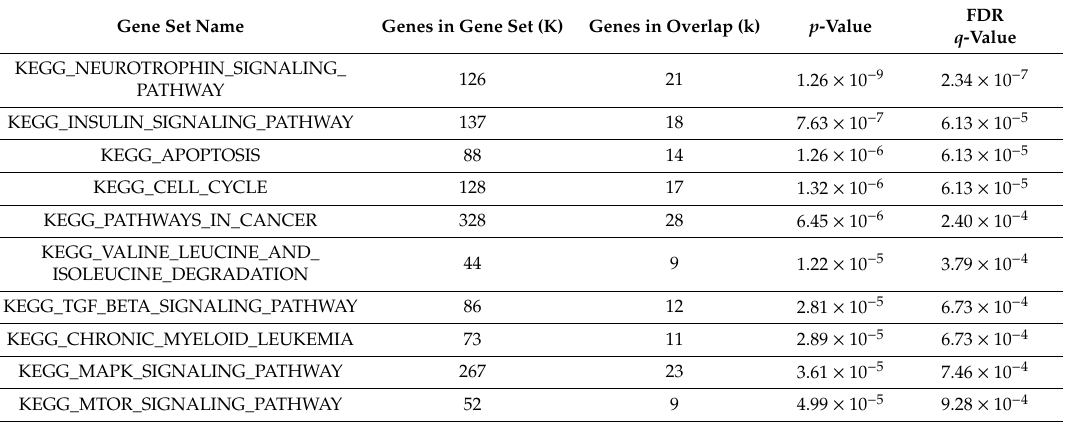
Table 2. Gene enrichment analysis GSEA (curated gene